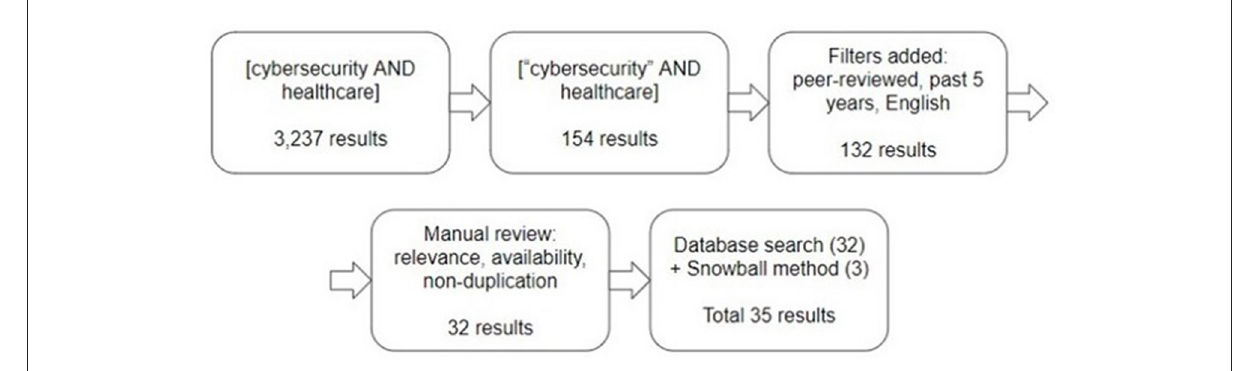
FIGURE1 Literature review